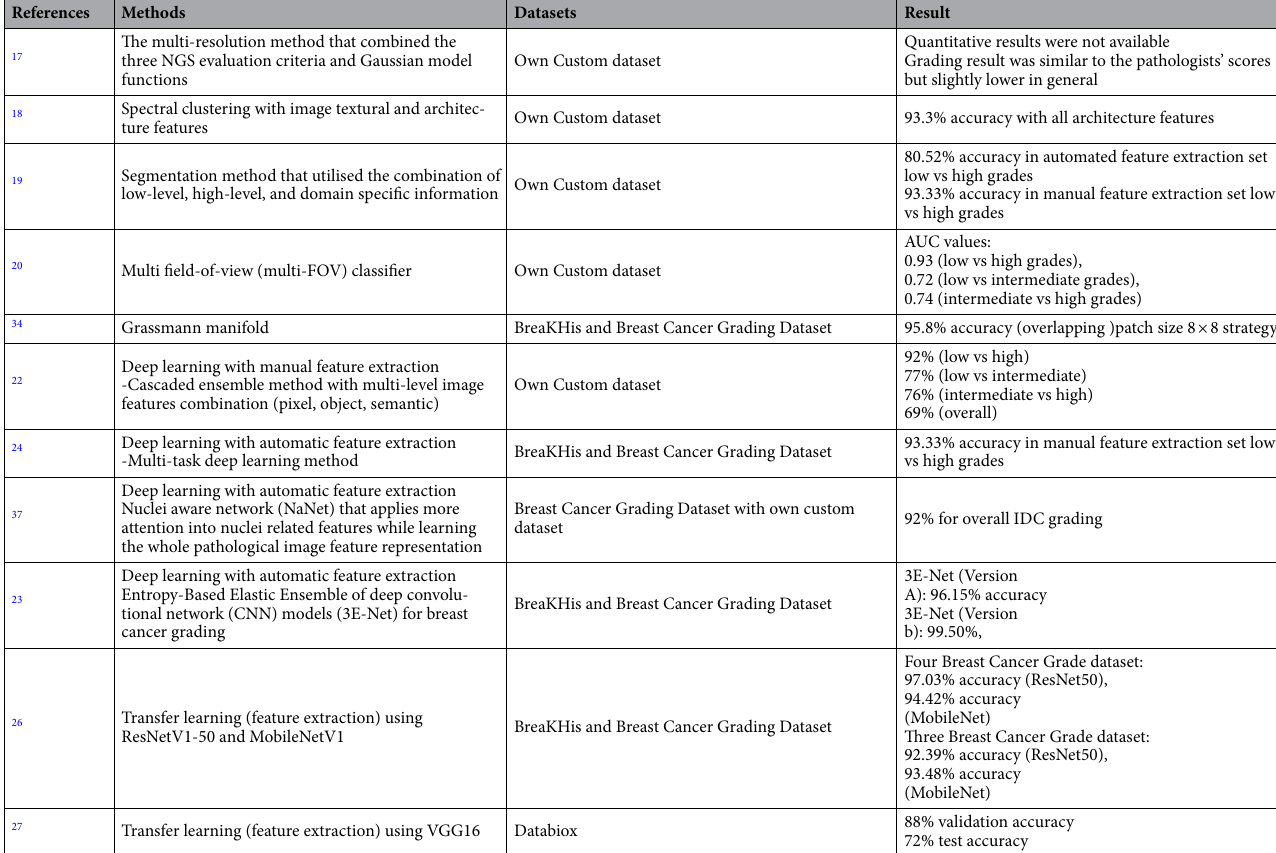
Table 1. This table summarises the methods and datasets adopted by previous studies on breast cancer grading.